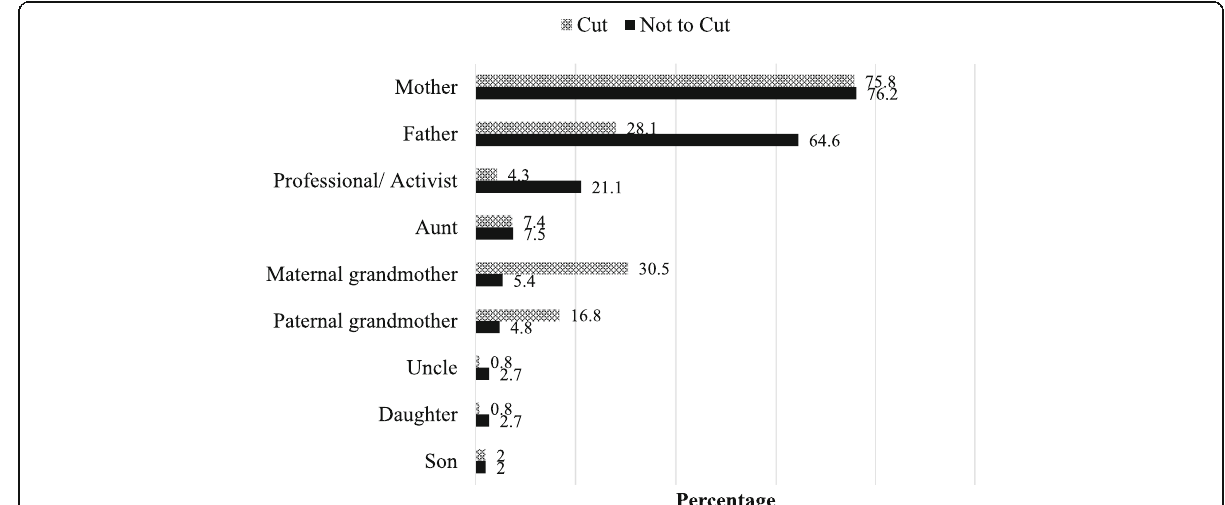
Fig. 1 People involved in household ’ s FGM/C-related decision